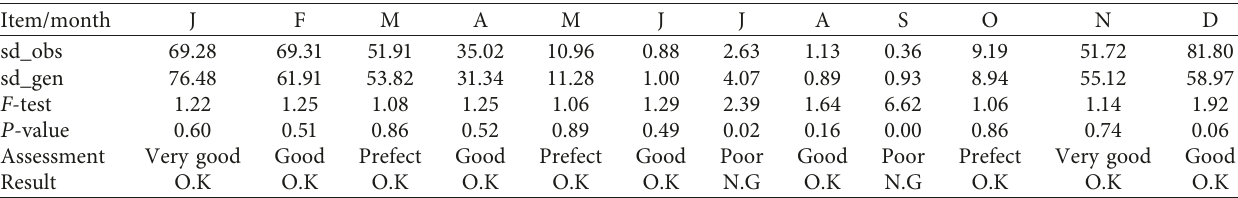
Table 5: Results of the F -test, standard deviation comparison of observational and simulated data by the model of the Doroudzan